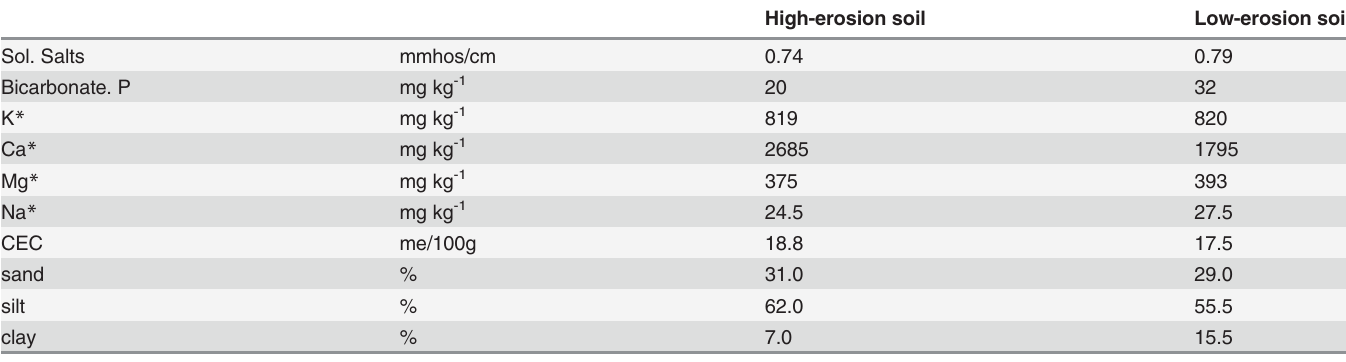
Table 1. Texture, pH and base content of the soils used in the study.